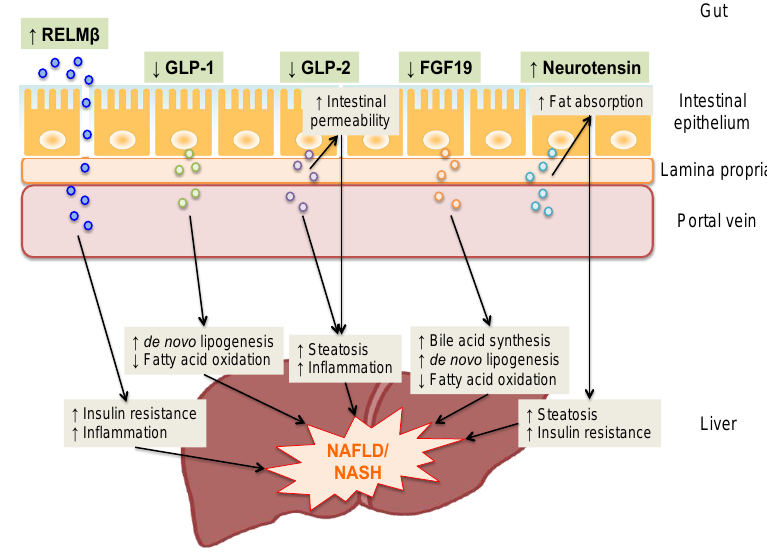
Figure 3. Summary of the putative roles of gut-derived secretory factors in the pathogenesis of NAFLD/NASH on the basis of the gut-liver axis. Resistin like molecule β (RELM β ) is secreted by goblet cells and delivered from the intestinal lumen into the lamina propria through a disrupted epithelial barrier, and then translocates into the portal vein and reaches the liver. Glucagon-like peptide-1 (GLP-1), glucagon-like peptide-2 (GLP-2), fibroblast growth factor (FGF) 19 and neurotensin are released from enteroendocrine cells into the lamina propria and reach the liver through the portal vein. Increased intestinal secretion and circulating RELMβ and neurotensin levels and decreases in those of GLP-1, GLP-2 and FGF19 could be involved in the pathogenesis of non-alcoholic fatty liver disease (NAFLD)/non-alcoholic steatohepatitis (NASH) in various ways.